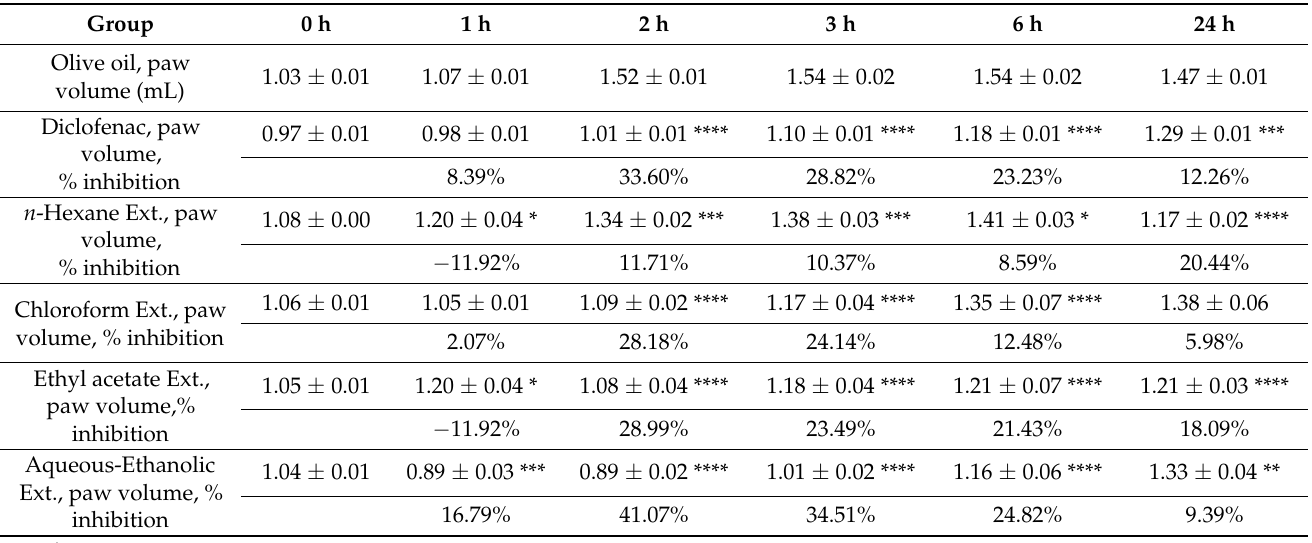
Table 5. Inhibition of inflammation by S. cyclophylla extracts following carrageenan-induced paw edema in rats ‡ . Group 0 h 1 h